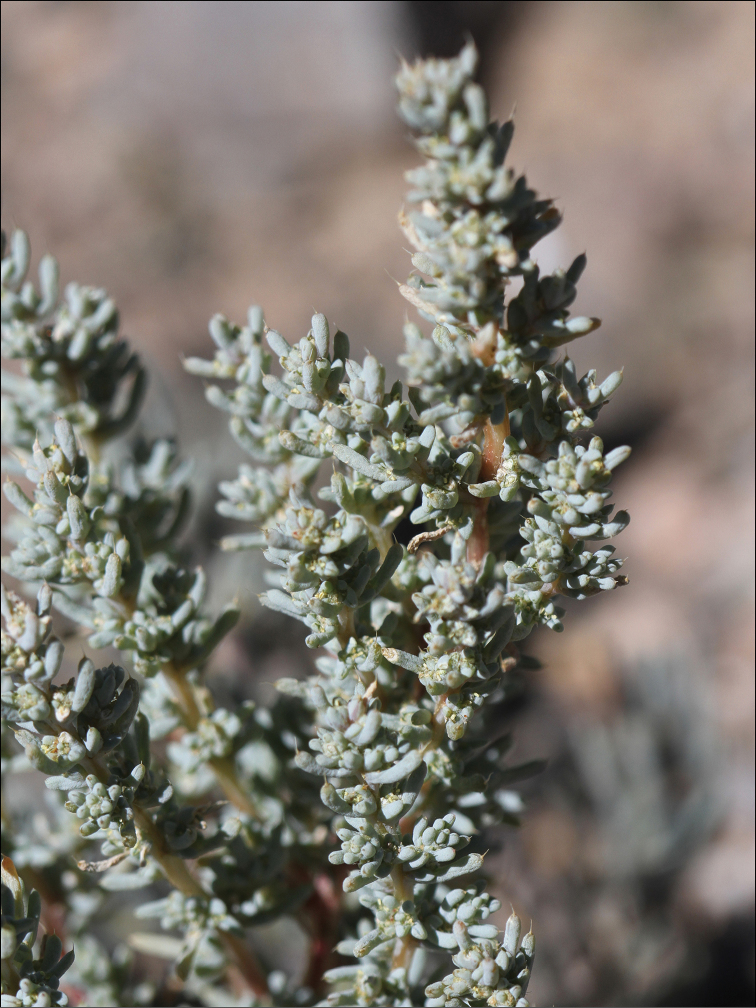
Halogetonglomeratus at blooming stage. Photograph by Dr. Oyuntsetseg Batlai (between Khavtag mountain and Baitag mountain range, Altai sum, Khovd province, Mongolia, 10 August 2017).